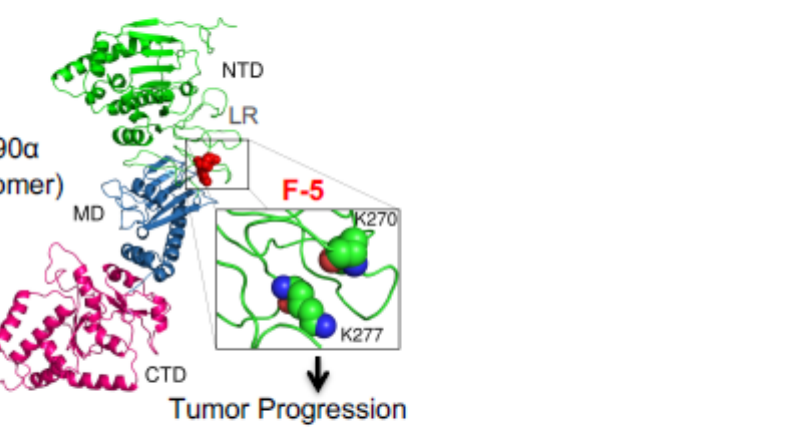
Figure 3. The F-5 fragment is located at the surface of the Hsp90 α protein. Based on the previously evaluated crystal structure of a monomer Hsp90 α protein with the NTD (green), MD (blue) and CTD (red) domains, the F-5 fragment containing Lysine-270 and lysine-277 is located in the unstructured linker region (LR) between the NTD and MD domains. Inhibitors such as monoclonal antibodies, targeting the dual lysine residues (in enlarged box), are potential anti-tumour therapeutics.